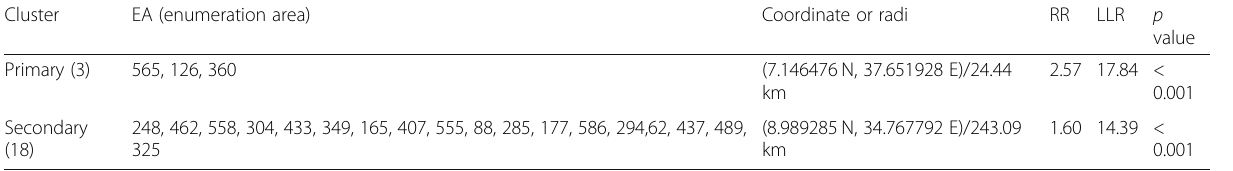
Table 2 SaTScan analysis results of childhood diarrhea among under-five children in Ethiopia, 2016 Cluster